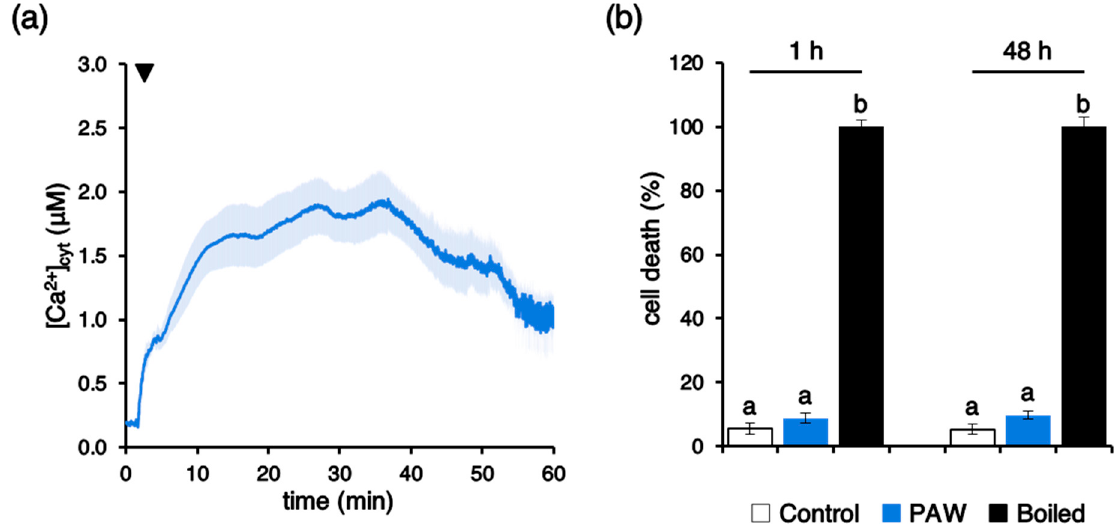
Figure 5. The long-lasting [Ca 2+ ] cyt elevation induced by PAW is not cytotoxic. ( a ) Ca 2+ measurement assays were conducted in aequorin-expressing Arabidopsis seedlings. At 100 s (arrowhead) seedlings were challenged with a 1:4 dilution of PAW generated by exposing deionized H 2 O to cold plasma for 5 min at 900 W torch #1 power. Changes in [Ca 2+ ] cyt were continuously recorded for 1 h. Data are the means (solid lines) ± SE (shading) of six different seedlings derived from three independent growth replicates; ( b ) viability of Arabidopsis cell suspension cultures treated with PAW (1:4 diluted) for either 1 h or 48 h (blue bars). Control cells were incubated with cell culture medium only (white bars). The 100% value corresponds to cells treated for 10 min at 100 °C (black bars). Bars labelled with different letters differ significantly ( p < 0.05, Student’s t test).